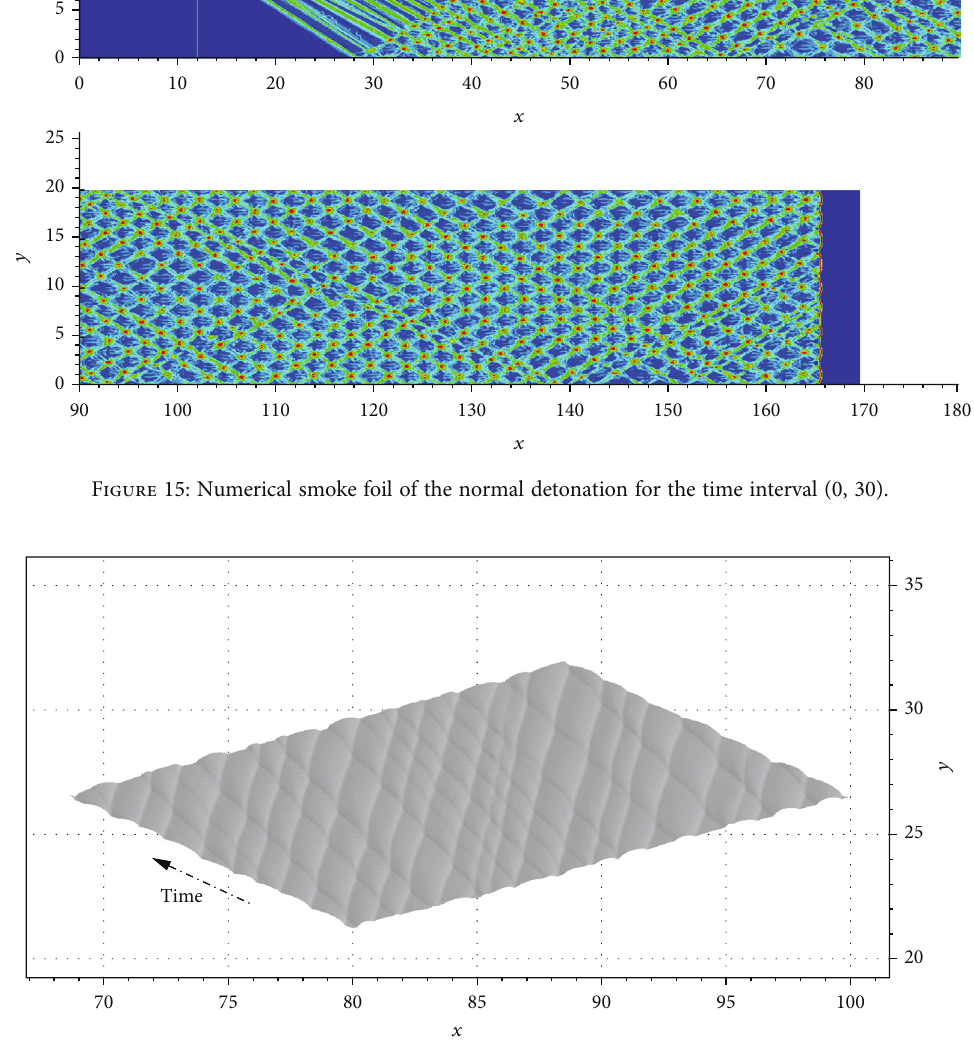
Figure 16: Numerical smoke foil of the oblique detonation with a larger computational domain.